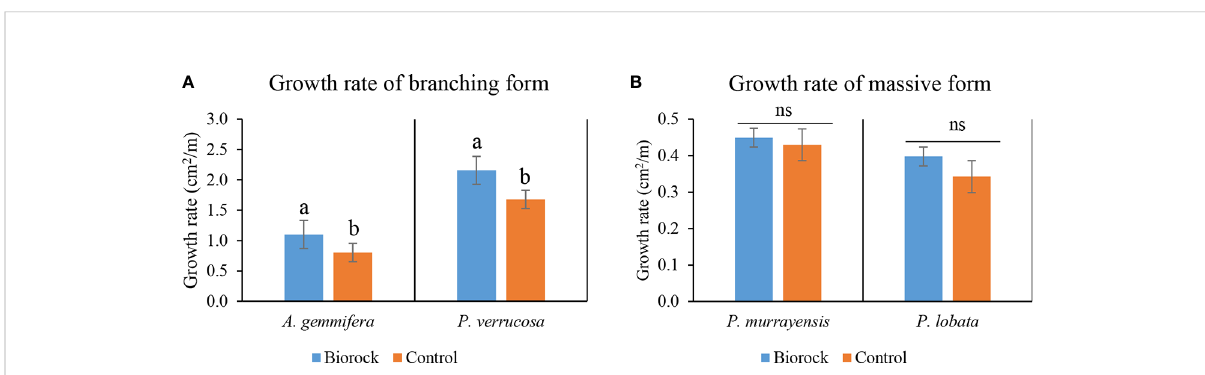
FIGURE 7 (A) Mean growth rate (mean ± SE) of branching corals; light blue and orange represent the growth rates of A. gemmifera and P. verrucosa on treatment structures and control. (B) Mean growth rate (mean ± SE) of massive corals; light blue and orange represent the growth rates of P. murrayensis and P. lobata on treatment structures and control; (ns, not signi fi cant, a different letter is given when comparison between two groups was signi fi cant, p<